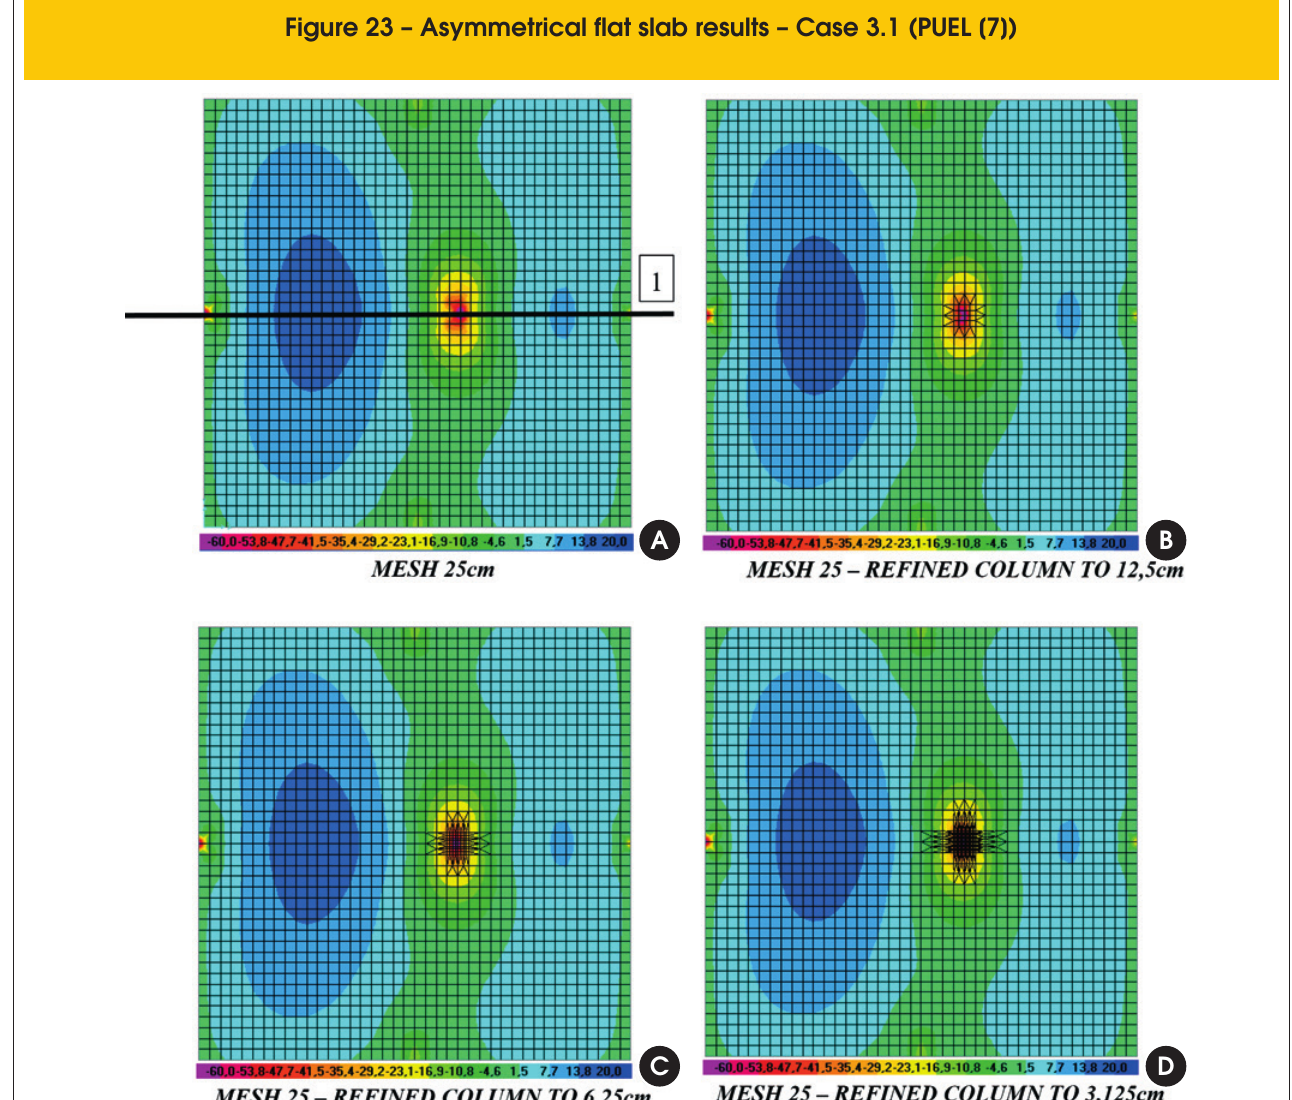
Figure 23 – Asymmetrical flat slab results – Case 3.1 (PUEL